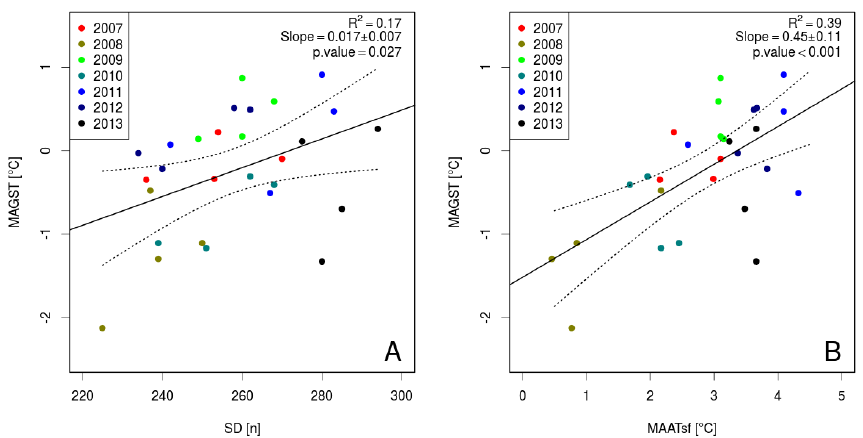
Figure 5. Scatterplots of SD (a) and MAATsf (b) against MAGST. The solid line represents the linear fit while the dotted lines are the confidence intervals. The metrics of the fitting are also reported.